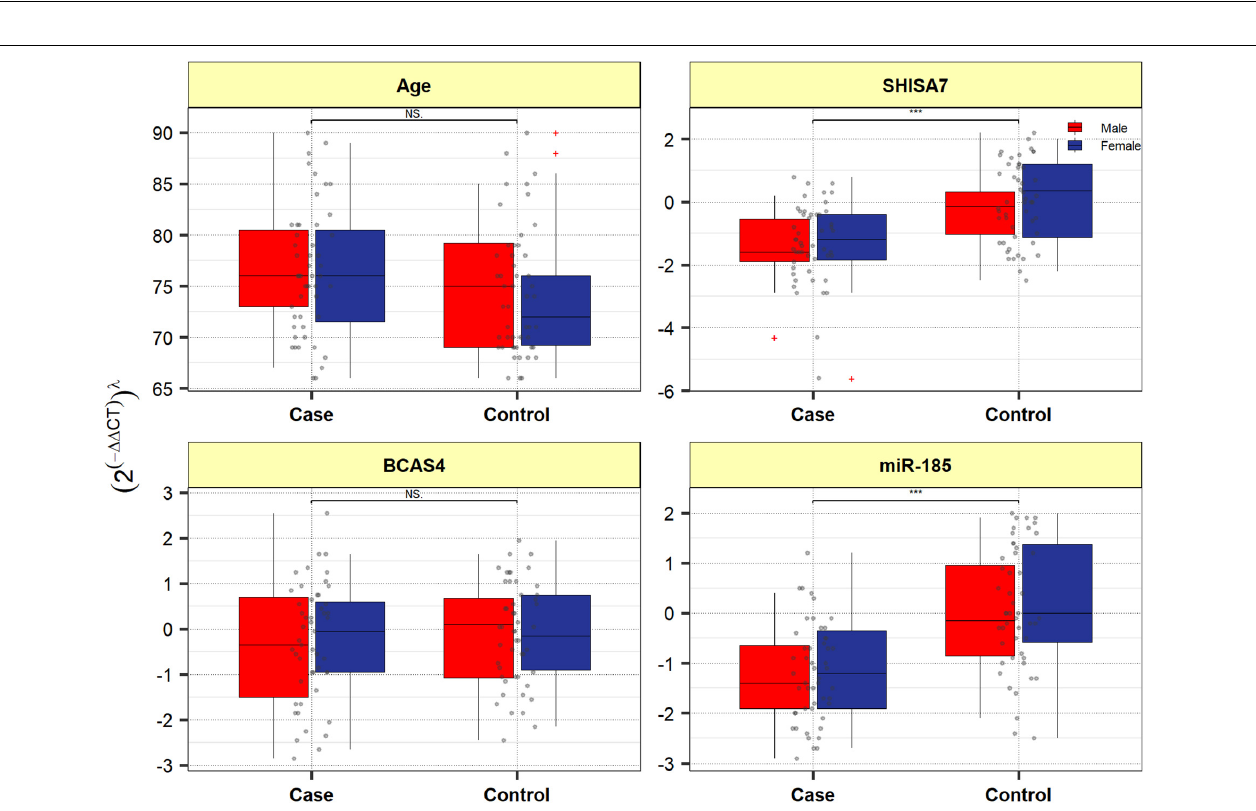
FIGURE 4 | Expression of BCAS4, SHISA7, and hsa-miR-185-5p in cases and controls’ peripheral blood samples. Values are depicted as gray dots. Means of expression levels and interquartile range are displayed.